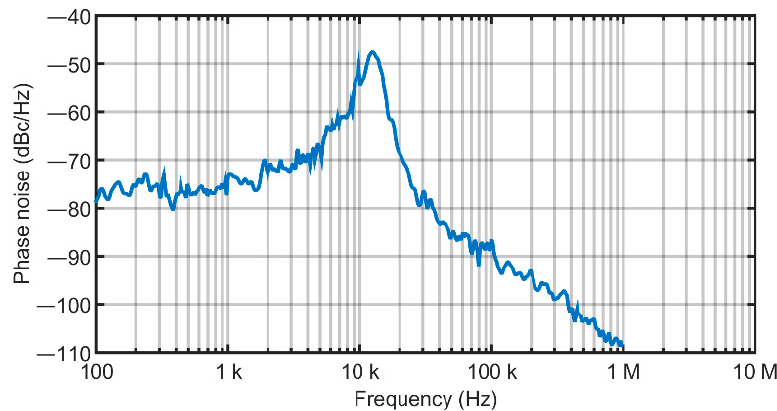
Figure 8. Frequency response of the developed measurement system.